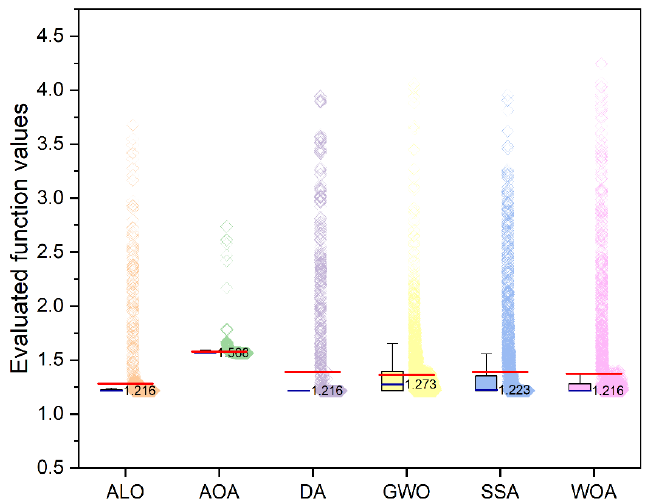
Figure 4. Box plots denoting the spread of all the function evaluations during WR optimization in a typical independent run. The horizontal blue line (and numeric value) and the red line indicate the median and mean of all the function evaluations.